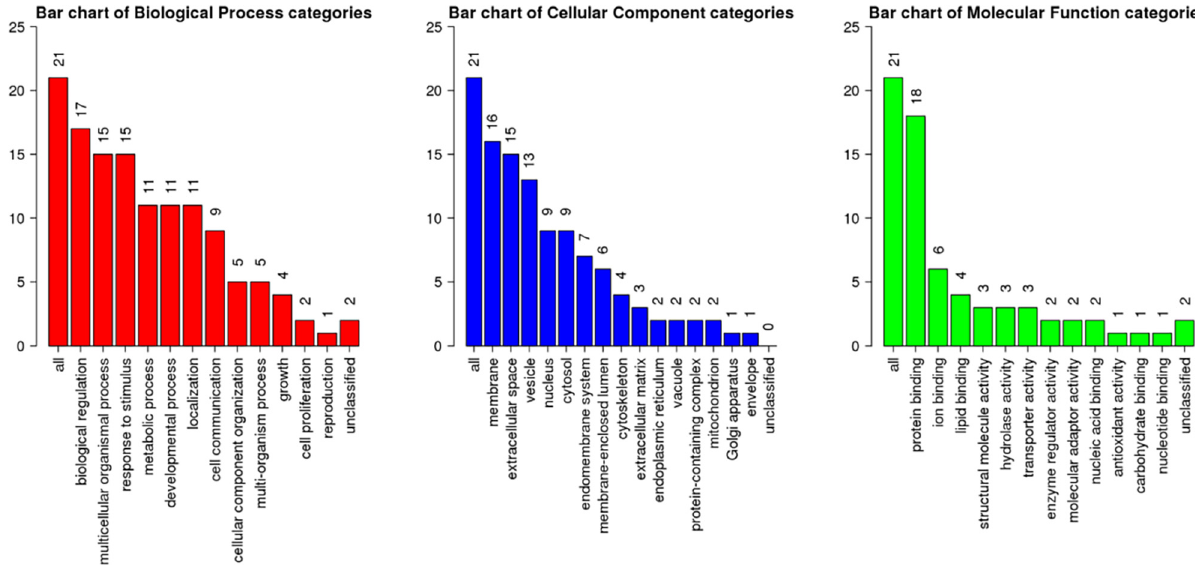
Figure 5: Analysis of biological processes, cell components, and molecular functions involved in the interaction with CRABP2